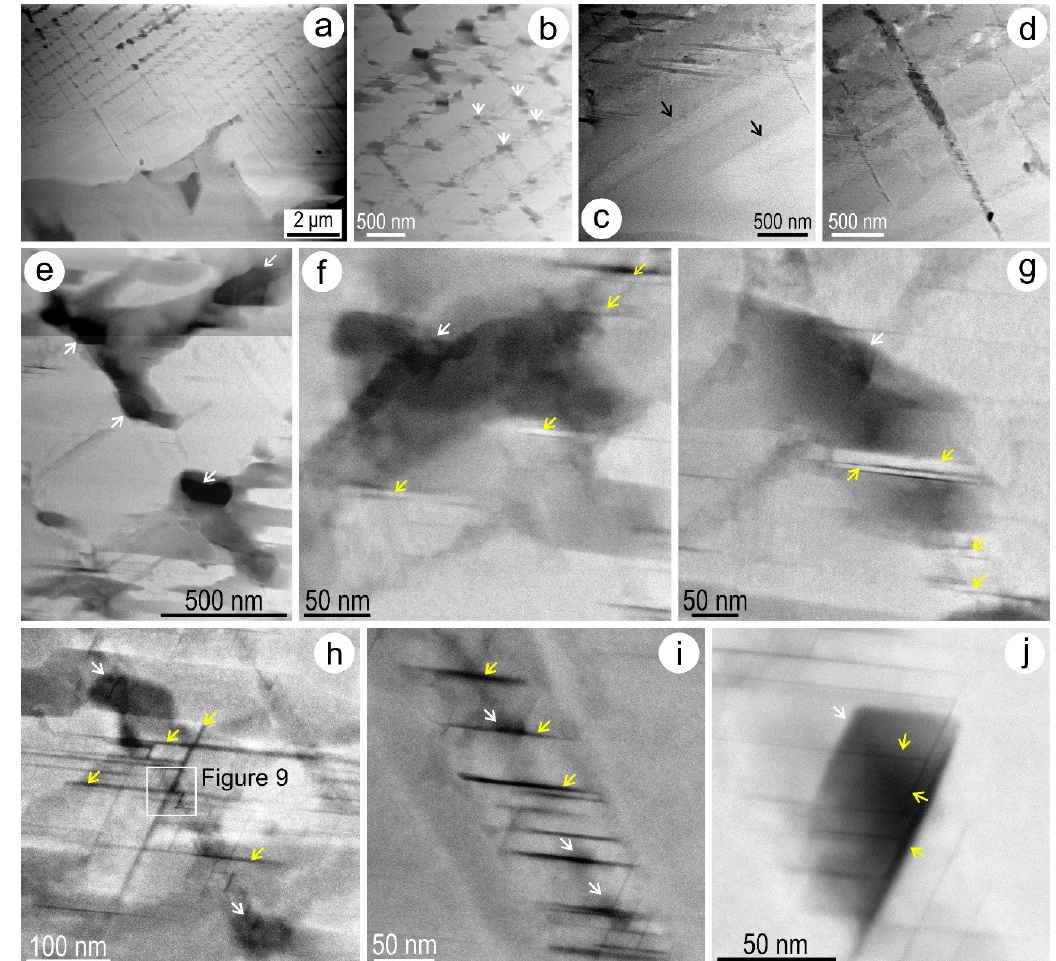
Figure 5. Low-resolution HAADF STEM images showing inclusion networks and phase associations throughout titanomagnetite (Ti-Mt). ( a ) Field of view on the S/TEM foil in Figure 4c showing the gradual change in inclusion density across the titanomagnetite and areas that were studied in closer detail, as marked. ( b ) Typical rectangular network with spinel minerals (arrowed) at the junctions between {100} planes hosting ilmenite (Ilm) lamellae. ( c ) Margin showing a set of brighter bands (arrowed) with darker rims in titanomagnetite. These are oriented along the {100} planes rather than forming a rectangular network. ( d ) Details of the margin showing inclusions along a second array of planes crosscutting the brighter bands in titanomagnetite. Note these are irregular with respect of length and width. ( e – g ) Details of the rectangular network of inclusions characteristic for the inner part of the grain. Note that spinel minerals (arrowed) are surrounded by irregular areas of ilmenite and titanomagnetite. In addition, thin lamellae with brightest intensity (yellow arrows) underline {111} planes crosscutting the rectangular {100} network. ( h – j ) Details of the second inclusion arrays in ( d ). These shows both spinel (white arrows) and a lamellar {111} network with phases that appear darkest in the images (yellow arrows).